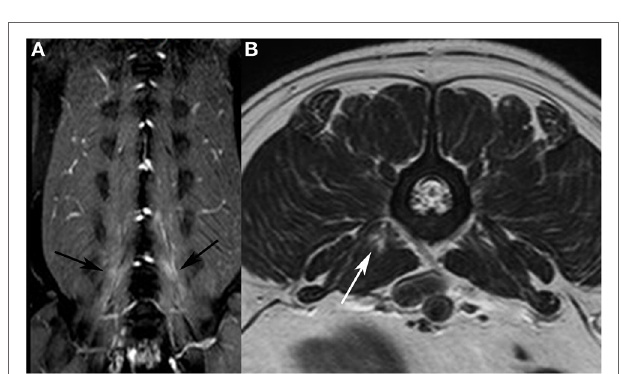
FigUre 2 | Dorsal T2-weighted (T2W) fat-suppressed image of a French bulldog presented with intervertebral disk extrusion at the level L5/L6. (a) bilateral signal alterations are visible in the hypaxial muscles (black arrows). On the T2W fast spin echo transverse image (B) , only a focal area of increased signal intensity is visible in the M. psoas major on the right side (white arrow).